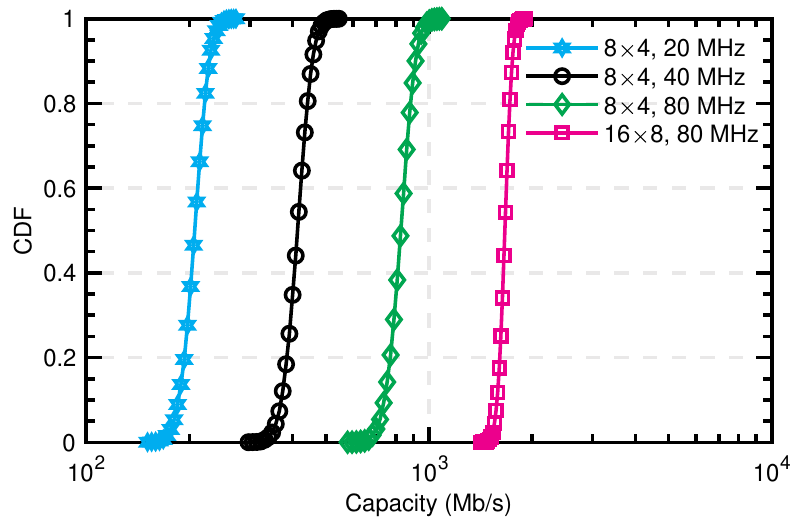
Figure 10. Performance analysis of MIMO scheme for different channel widths and antenna configu- rations based on the cumulative distribution function of